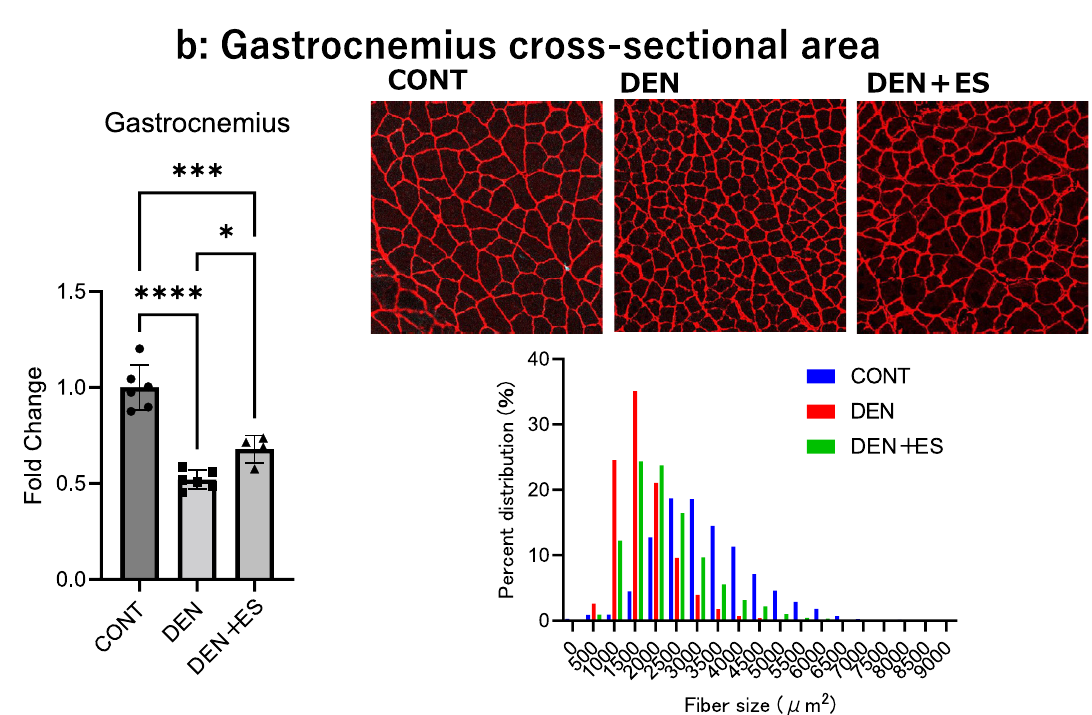
Figure 3. Muscle fiber cross-sectional area (CSA) of TA ( a ) and GAS ( b ) after belt electrode chronic stimulation. Mean ± SD. One-way ANOVA test was used to evaluate changes in the muscle fiber CSA of the lower limb muscles 24 h after chronic stimulation with belt electrodes. CONT, unstimulated control group; DEN, denervation muscle atrophy induced by DEN + ES, denervation muscle atrophy induced + electrical stimulation by belt electrode group; *p < 0.05, **p < 0.01, ***p < 0.001, ****p <